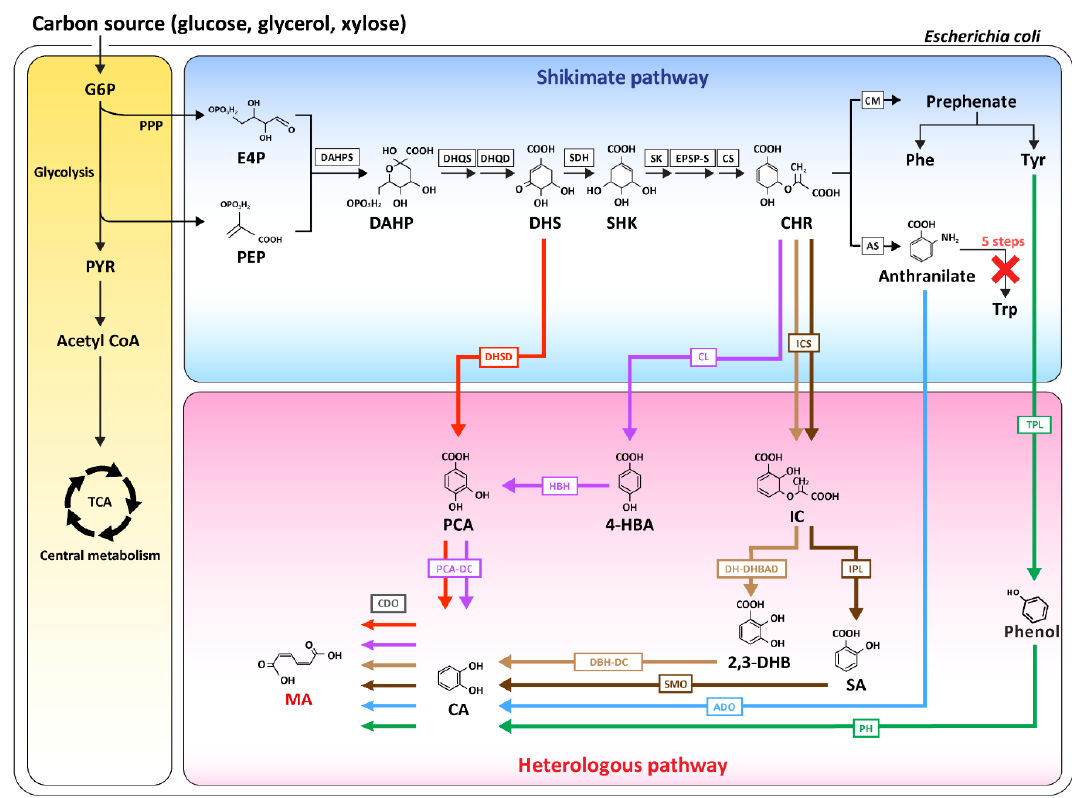
Figure 1. Schematic overview of the metabolic pathway for MA biosynthesis in E. coli . The red arrow (pathway 1), purple arrow (pathway 2), tan arrow (pathway 3), brown arrow (pathway 4), blue arrow (pathway 5), and green arrow (pathway 6) represent MA biosynthetic pathways 1, 2, 3, 4, 5, and 6, respectively. G6P, glucose-6- phosphate; PPP, pentose phosphate pathway; PYR, pyruvate; PEP, phosphoenolpyruvate; E4P, erythrose4-phosphate; DAHP, 3-deoxy-D-arabinoheptulosonate-7-phosphate; DHS, 3-dehydroshikimate; SHK, shikimic acid; Phe, phenylalanine; Tyr, tyrosine; Trp, tryptophan; CHR, chorismate; 4-HBA, 4-hydroxybenzoate; IC, isochorismate; 2,3-DHB, 2,3-dihydroxybenzoate; SA, salicylate; PCA, protocatechuate; CA, catechol; MA, muconic acid. DAHPS, DAHP synthase; DHQS, DHQ synthase; DHQD, DHQ dehydratase; SDH, shikimate dehydrogenase; SK, shikimate kinase; EPSP-S, 5-enolpyruvylshikimate-3-phosphate synthase; CS, chorismate synthase; CM, chorismate mutase; AS, anthranilate synthase; DHSD, DHS dehydratase; PCA-DC, protocatechuate decarboxylase; CDO, catechol 1,2-dioxygenase; TPL, tyrosine phenol lyase; PH, phenol hydroxylase; CL, chorismate pyruvate-lyase; ICS, isochorismate synthase; IM, isochorismatase; DH-DHBAD, 2,3-dihydro-2,3-DHBA dehydrogenase; IPL, isochorismate pyruvate lyase; DBH-DC, 2,3-dihydroxybenzoate decarboxylase; SMO, salicylate 1-monoxygenase; ADO, anthranilate 1,2-dioxygenase.